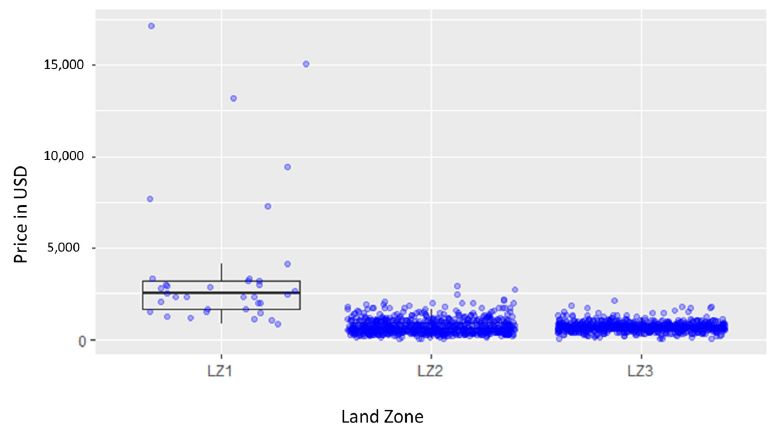
Figure 8. Actual urban land prices per m 2 in USD by land zone. Therefore, the land price, as is depicted according to the location (center to periph- ery), showed a declining trend (0–5 km) and was comparatively less responsive as it moved from LZ2 and LZ3, which span from 5 to 16.97 km (Figure 9). In the respective land zones, other land price attributes could be more explanatory than the distance from the center. However, an analysis of variance indicated that there is a significant land price difference between the delineated land zones (Table 1). In this case, price is assumed to capture the land value, which includes several urban land-actor-preferred variables, but such a nonlinear land lease price trend beyond the CBD could be a good starting point for future research on the contributions of distances from basic urban utilities, such as access to transportation routes, to land price determinations. Figure 9. Actual urban land prices per m 2 in USD against distance from the center in kilometers and categorized by land zone. Here, the hypothesis established was that mean land price equality never holds across all land zones (x ̄ LZ1 = x ̄ LZ2 = x ̄ LZ3), where x ̄ is the sample mean, and LZ is the